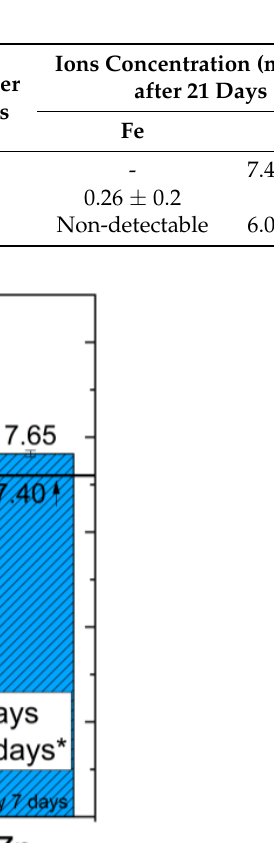
Table 2. Changes in pH after 7 and 21 days of material immersion in Hanks ´ solution at 37 ± 0.2 ◦ C with corresponding ions concentrations determined by atomic absorption spectroscopy (AAS).